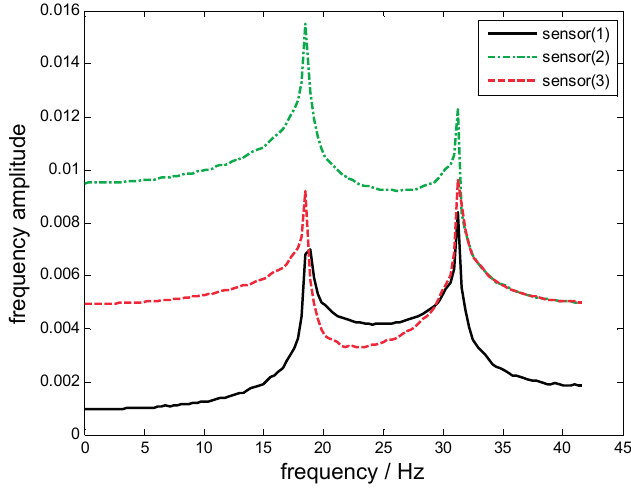
Figure 6. The frequency spectra of sample streams with 83.3 Hz.